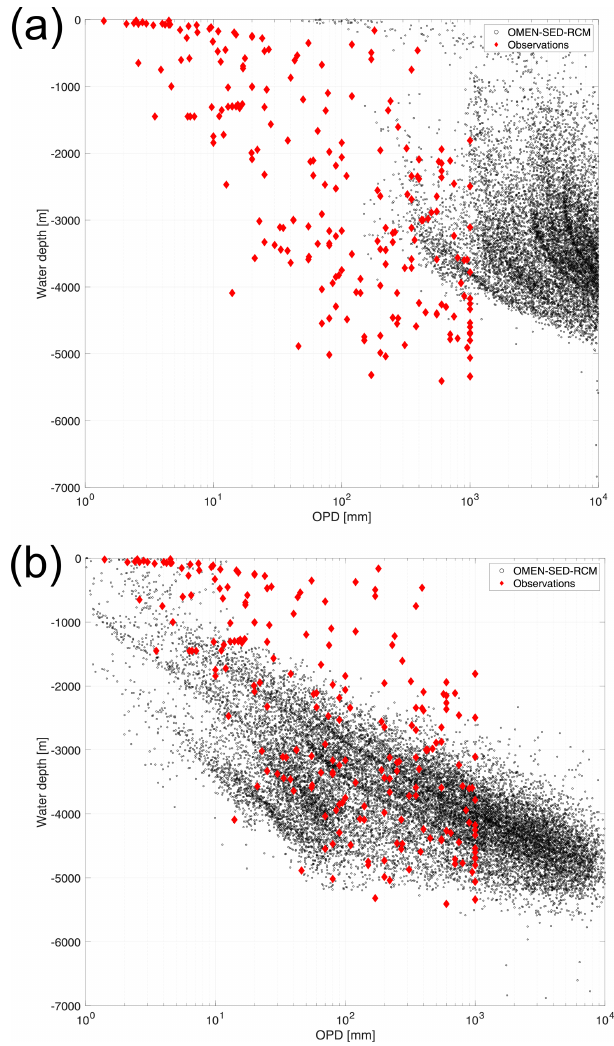
Figure 6. Water depth versus OPD for (a) the original a – ω relation- ship (Eq. 13) and (b) the rescaled a – ω relationship. OMEN-SED- RCM results are shown as black circles. Observations (shown as red diamonds) are taken from Jahnke et al. (1989), Canfield et al. (1993), Glud et al. (1994), Glud et al. (1998), Glud et al. (1999), Glud et al. (2003), Glud et al. (2009), Wenzhöfer et al. (2001a), Wenzhöfer et al. (2001b), Black et al. (2001), Giordani et al. (2002), Wenzhöfer and Glud (2002), Lansard et al. (2008), Lansard et al. (2009), Sachs et al. (2009), Witte et al. (2003a), Witte et al. (2003b) and Egger et al. (2018).